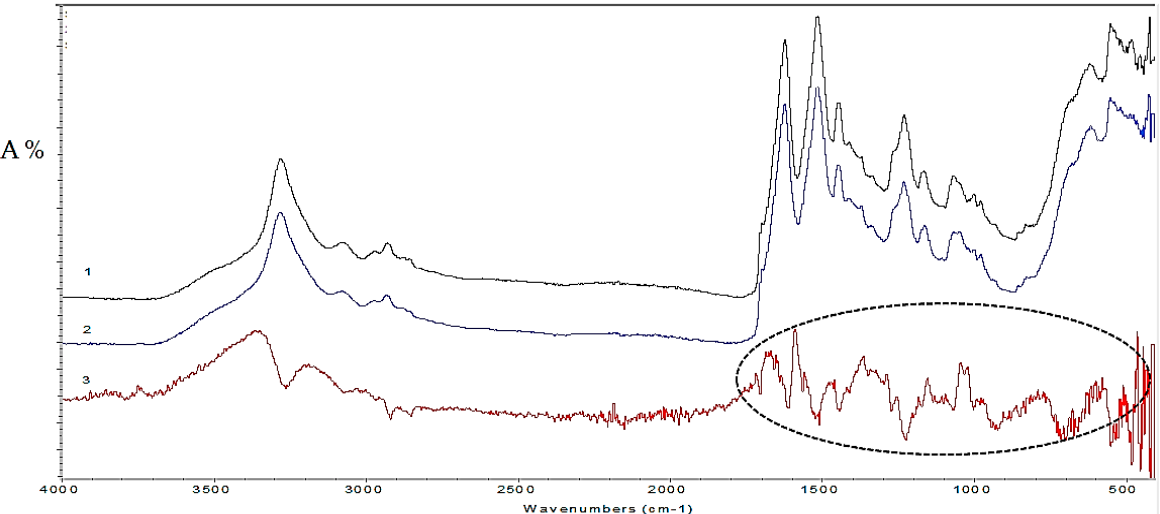
Figure 6. FTIR-ATR absorption spectra: 1-undyed sample of reference silk fibre, 2- Sample 1 , 3-dye spectrum obtained by spectral subtraction of reference silk spectra from the coloured sample spectrum.